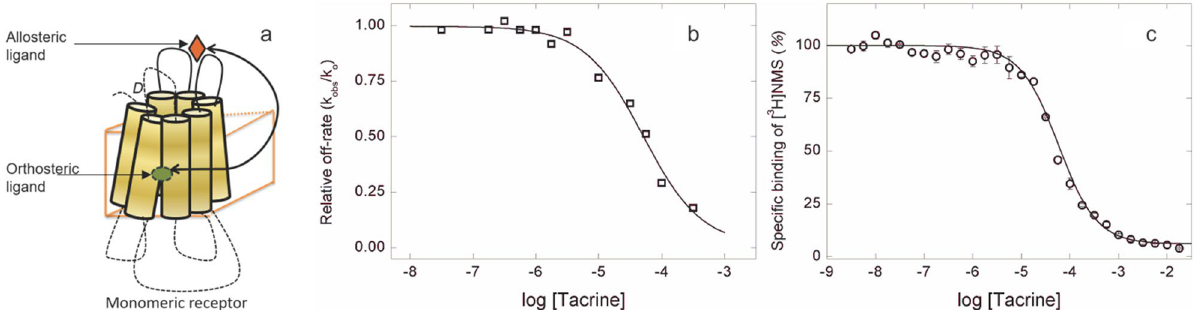
Figure 4. Effect of tacrine on the rate of dissociation and equilibrium binding of [ 3 H]NMS at monomers of the M 2 receptor purified from Sf 9 cells. ( a ) A graphic depiction of the interaction between allosteric and orthosteric ligands within a monomeric receptor. ( b ) Purified monomers were labelled with [ 3 H]NMS (10 nM), and the rate constant of dissociation was measured for the radioligand alone ( k 0 ) and together with tacrine ( k obsd ). The normalized rate constants ( k obsd / k 0 ) at graded concentrations of tacrine are shown in the figure, where the line depicts the best fit of Eq. (3) ( n = 1). The parametric values are as follows: log K = − 4.30 ± 0.13 and n H = 0.94 ± 0.19. ( c ) Purified monomers were mixed simultaneously with [ 3 H]NMS (10 nM) and tacrine at the concentrations shown on the abscissa, and binding was measured following incubation for 21 h at 30 °C. The data from 4 experiments were analyzed in terms of Eq. (3) ( n = 1), and the fitted curve is shown in the figure. The parametric values are as follows: log K = − 4.24 ± 0.02 and n H = 1.09 ±